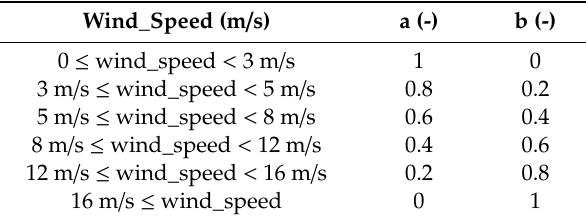
Table 3. Values assumed by a and b coe ffi cients.